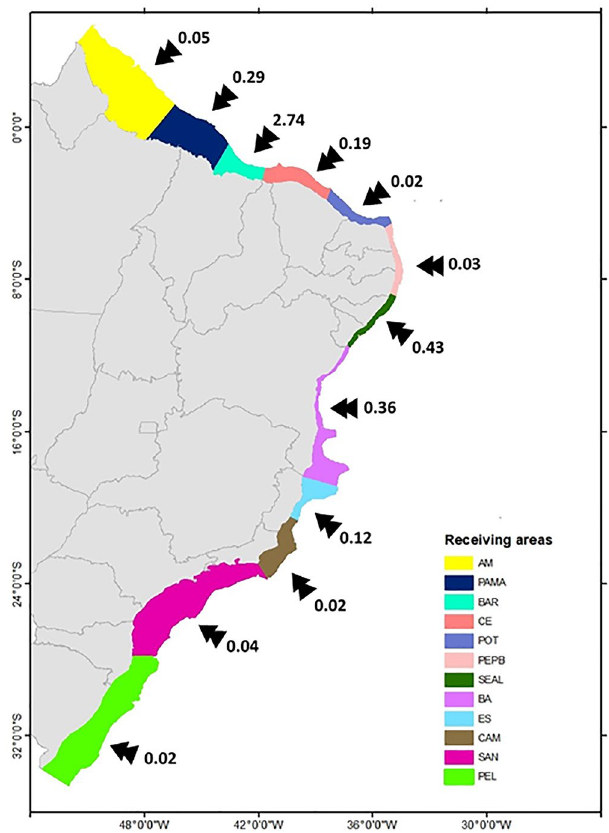
Figure 8. Total number of larvae per km 2 that reach each receiving area during all the experiments. Color code for the destination basins is in the insert and abbreviations are the same as in Fig. 6. Created with ArcGIS 10.6.1 (https:// www. esri.